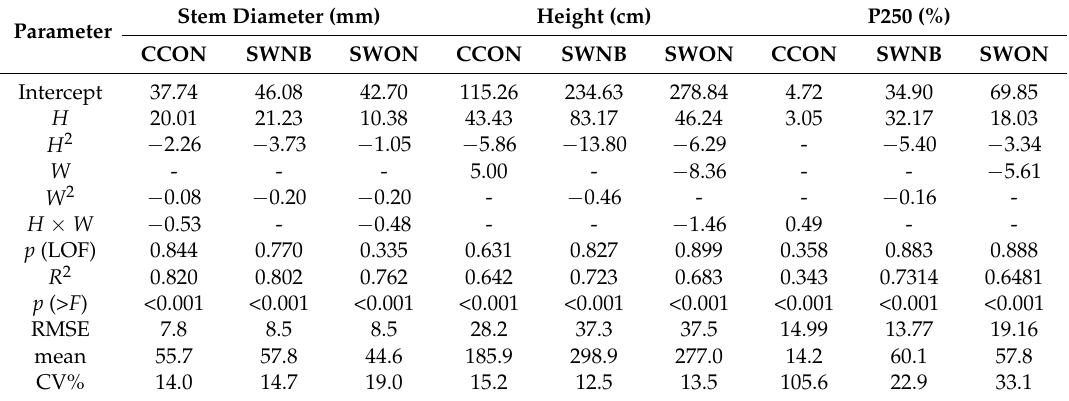
Table 2. Parameter estimates and fit statistics for age-10 response surfaces (model (1)) based on duration of herbaceous vegetation contol ( H , years) and timing of woody vegetation control ( W , year).